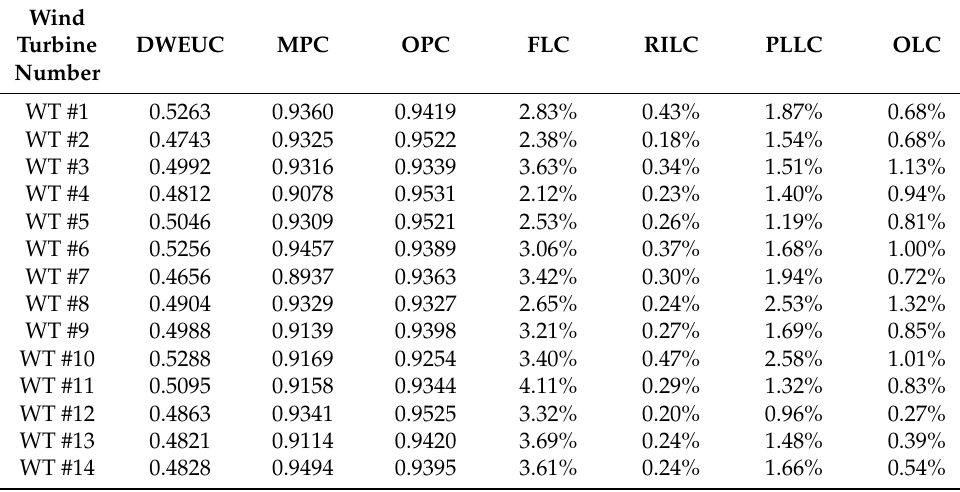
Table 3. The calculation results of comparative indicators of wind turbines.